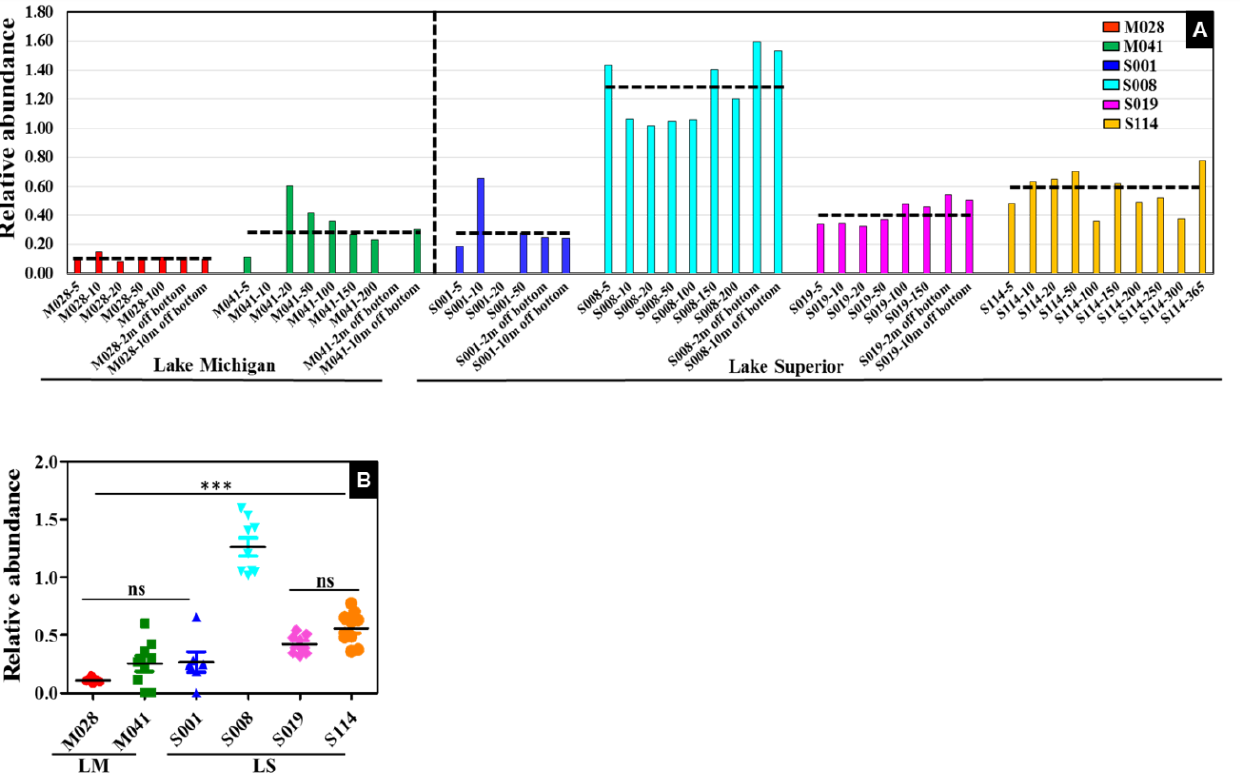
Figure 7. Distribution of Thaumarchaeota in the western Great Lakes. Shown are ( A ) relative abundance of phylum Thaumarchaeota at different depths in Lake Michigan and Lake Superior sampling locations, with relative abundance and sample name followed by depth shown in the x and y axes, respectively. Horizontal dashed line represents the mean abundance within each group. Lakes are separated by vertical black dashed lines. Samples are color coded to reflect sampling location in both the lakes. ( B ) The significant differences among the sampling locations for phylum Thaumarchaeota were computed using one-way ANOVA with Tukey’s post hoc test for multiple comparisons. *** p < 0.0001.